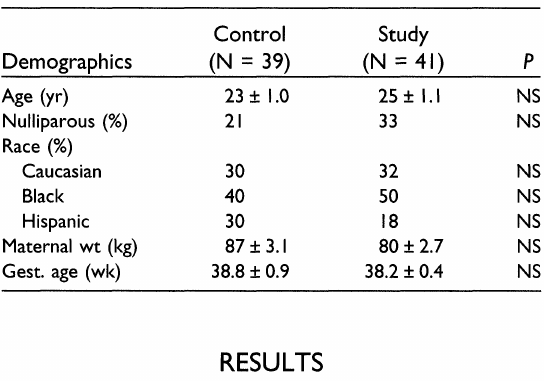
TABLE I. Population